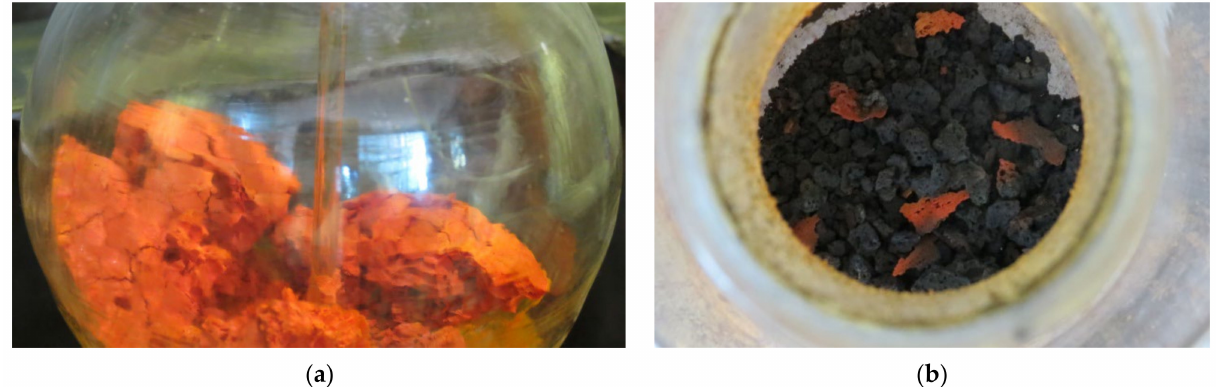
Figure 3. Appearance of the uranium powders obtained in the laboratory microwave denitration unit during the denitration of the uranyl nitrate solution: ( a ) after uranium trioxide sintering and ( b ) the final